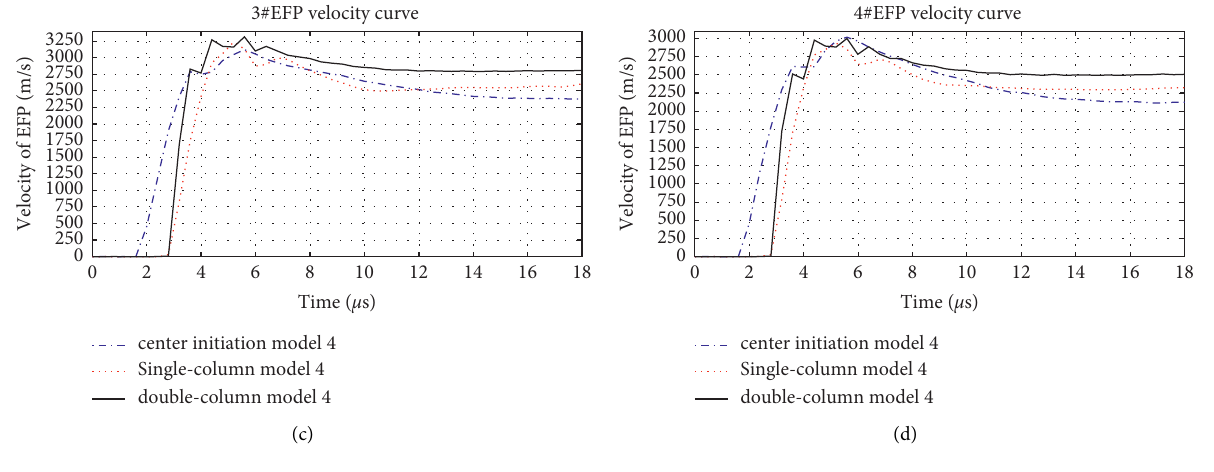
Figure 16: The velocity comparison of the fourth